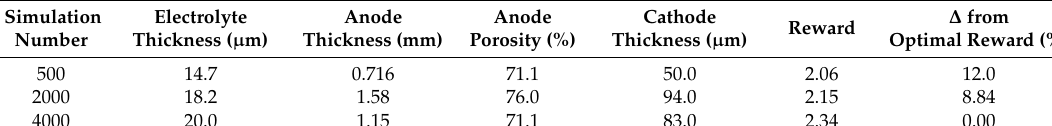
Table 3. Optimal design parameters from brute-force and MAB methods.